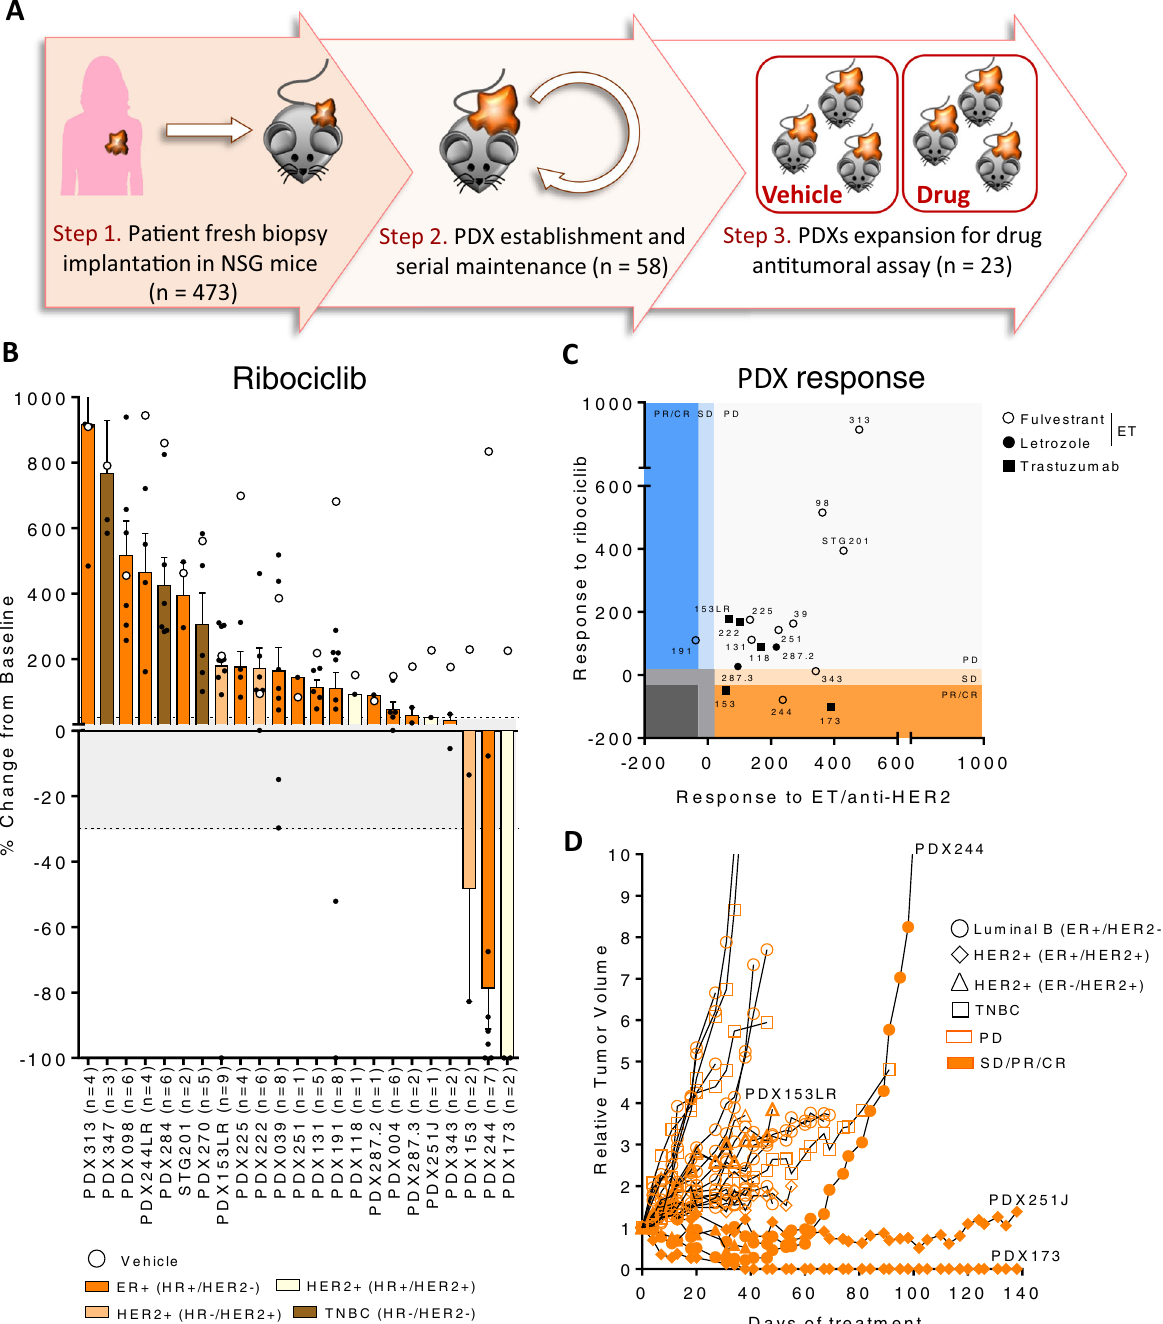
Fig. 1 | Ribociclib monotherapy has higher antitumor activity than other tar- getedagents in ER + and HER2 + BC PDXs.A Work fl ow depicting the generation of BCPDXmodelsfromBCpatientsamplesanditssubsequentexpansionfortargeted treatmentscreening. B Waterfallplotrepresentingthegrowthof n =23PDXtreated with ribociclib 75mg/kg (bars and black dots) and vehicle (white circles). The percentagechangefromtheinitialvolumeisshownatday35oftreatment.Dashed lines indicate the range of PD (>20%), SD (20% to − 30%) and PR/CR (< − 30%). The number of tumors treated per model is indicated in brackets ( n ). Data represent mean values and error bars ± SEM. C Antitumor response of ribociclib (y-axis) vs.